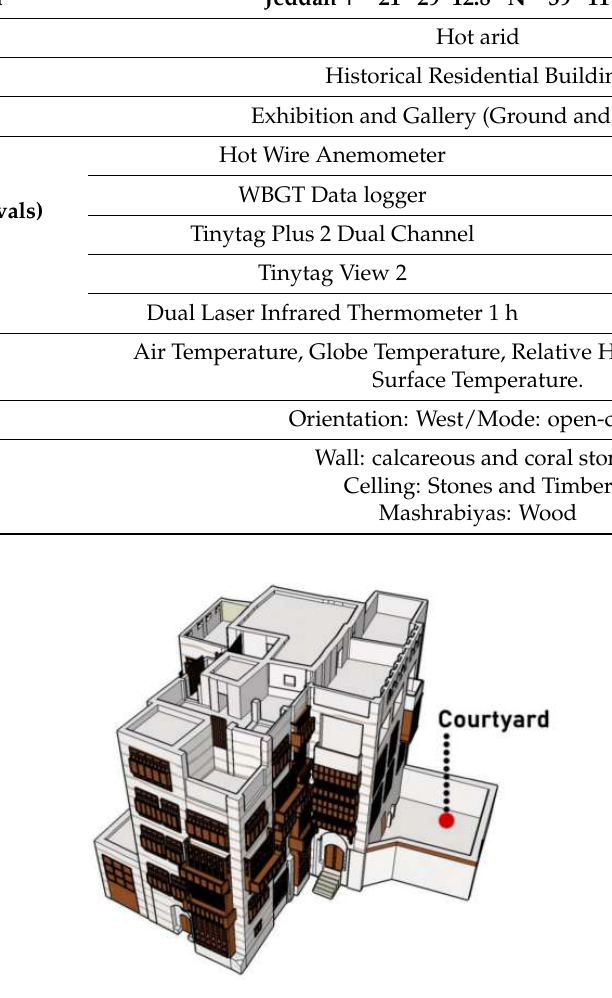
Figure 11. A 3D perspective of the building and the